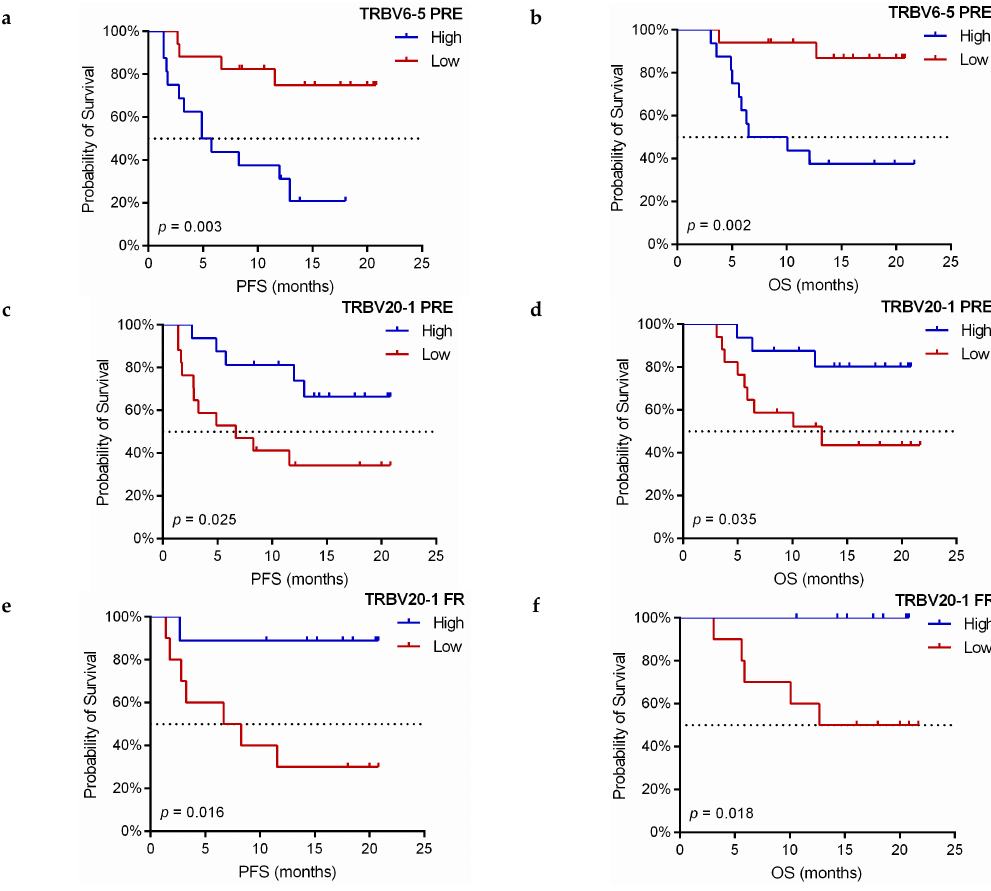
Figure 8. Kaplan – Meier survival curves according to V-gene usage in anti-PD-1 treated NSCLC patients. ( a , b ) Progression- free survival (PFS) and overall survival (OS) curves in terms of PRE TRBV6-5 frequency. ( c , d ) PFS and OS curves in terms of PRE TRBV20-1 frequency. ( e , f ) PFS and OS curves in terms of FR TRBV20-1 frequency. The median frequency values were used as cutoff values (2.53% for PRE TRBV6-5, 9.14% for PRE TRBV20-1, and 9.02% for FR TRBV20-1, respectively). PRE: pretreatment, FR: first response assessment, p -values were obtained using the log-rank test.